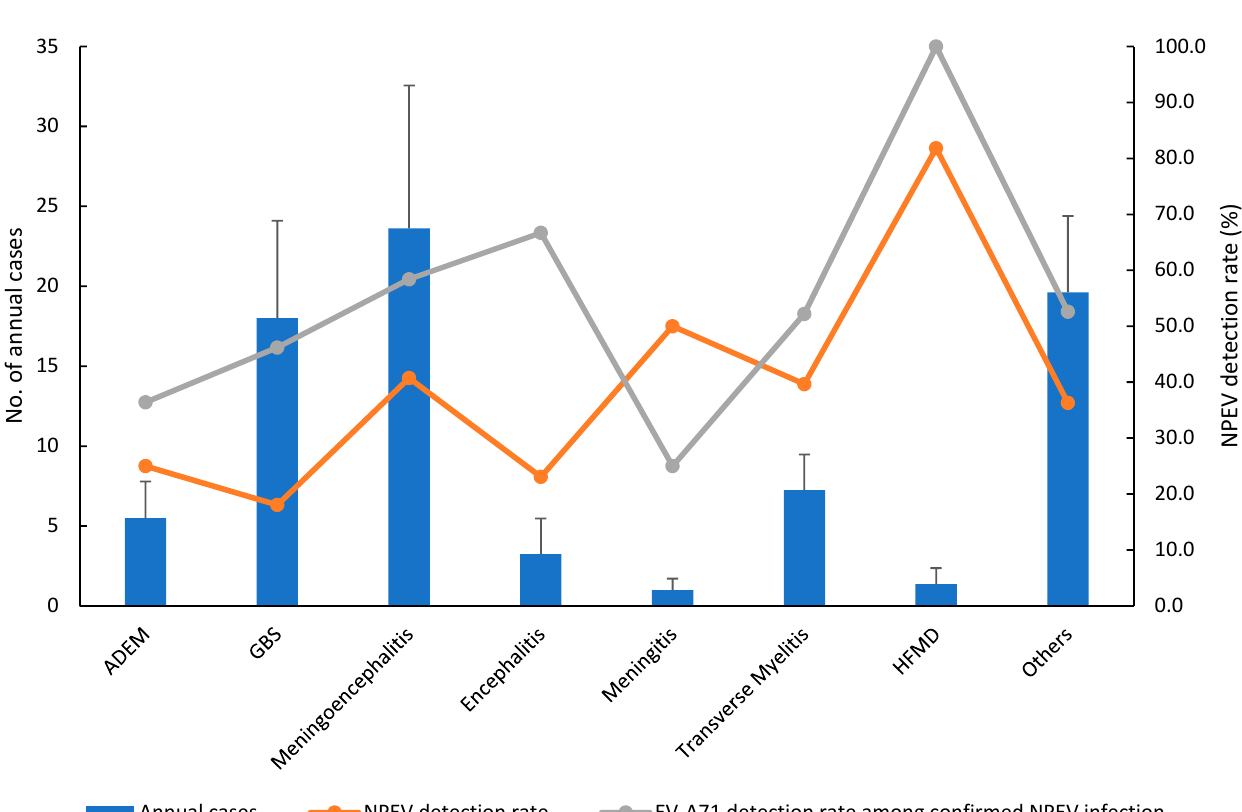
Figure 1. Monthly detection rate of AFP surveillance in Korea, 2012–2019.